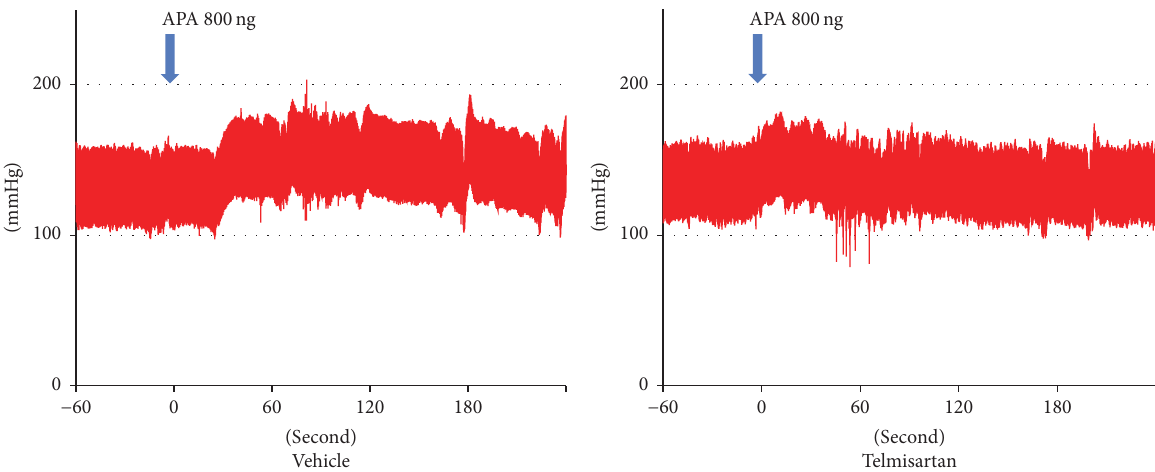
Figure 4: Representative traces of arterial pressure after intracerebroventricular (icv) administration of aminopeptidase A (APA) following pretreatment with telmisartan. Thirty minutes prior to the icv administration of 800 ng of APA, Wistar-Kyoto rats received icv administration of vehicle ( 𝑛 = 5 ) or 80 𝜇 g of telmisartan ( 𝑛 = 5 ) in a conscious, unrestrained state. Icv administration of telmisartan or vehicle did not change the baseline MAP. Pretreatment with telmisartan significantly attenuated the pressor response of APA. Arrow: time for APA administration.